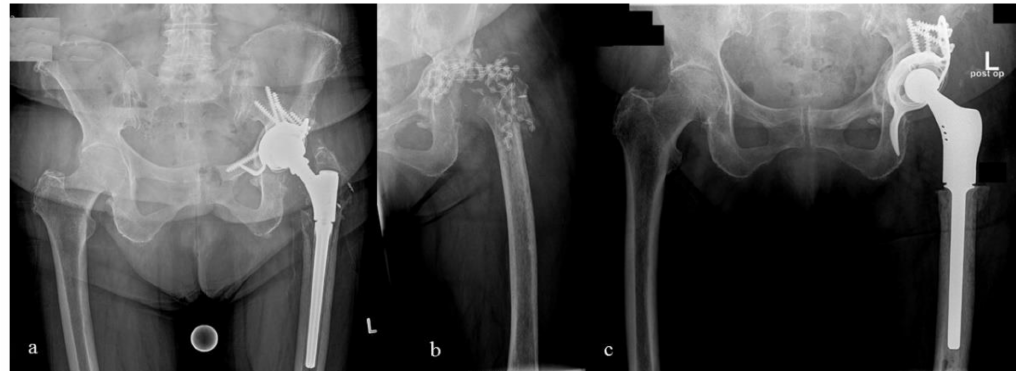
Figure 6. ( a ) Anterio-posterior radiographs of the pelvis of 78-year-old woman. Notice that anchors are already present in the major trochanter indicating a prior refixation; ( b ) During explantation, a refracture of the extremely weakened major trochanter occurred, so a resection arthroplasty was carried out instead of a spacer implantation; ( c ) Following an interim period of 54 days, the prosthesis reimplantation was performed (Burch-Schneider ® antiprotrusio cage, cemented polyethylene cup, Fa. ZimmerBiomet, Freiburg im Breisgau, Germany; GMRS ® , Fa. Stryker, Duisburg,